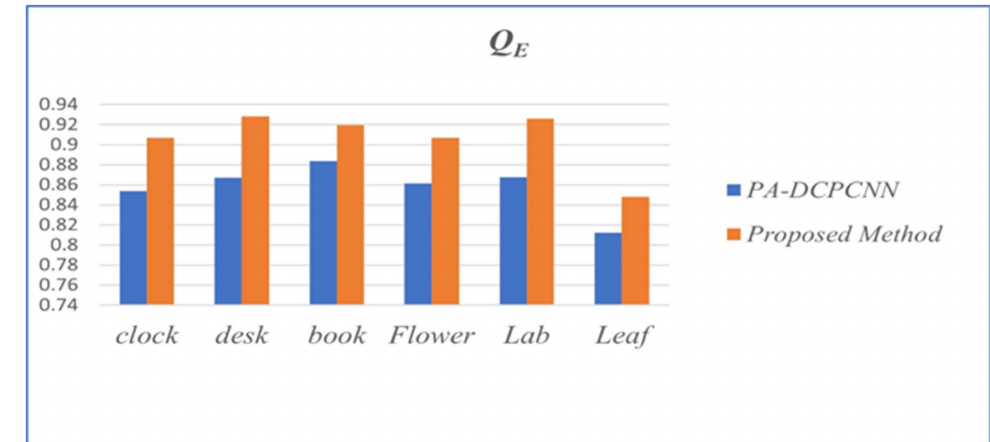
Figure 24. Performance evaluation of image-fusion techniques in reference to Q E